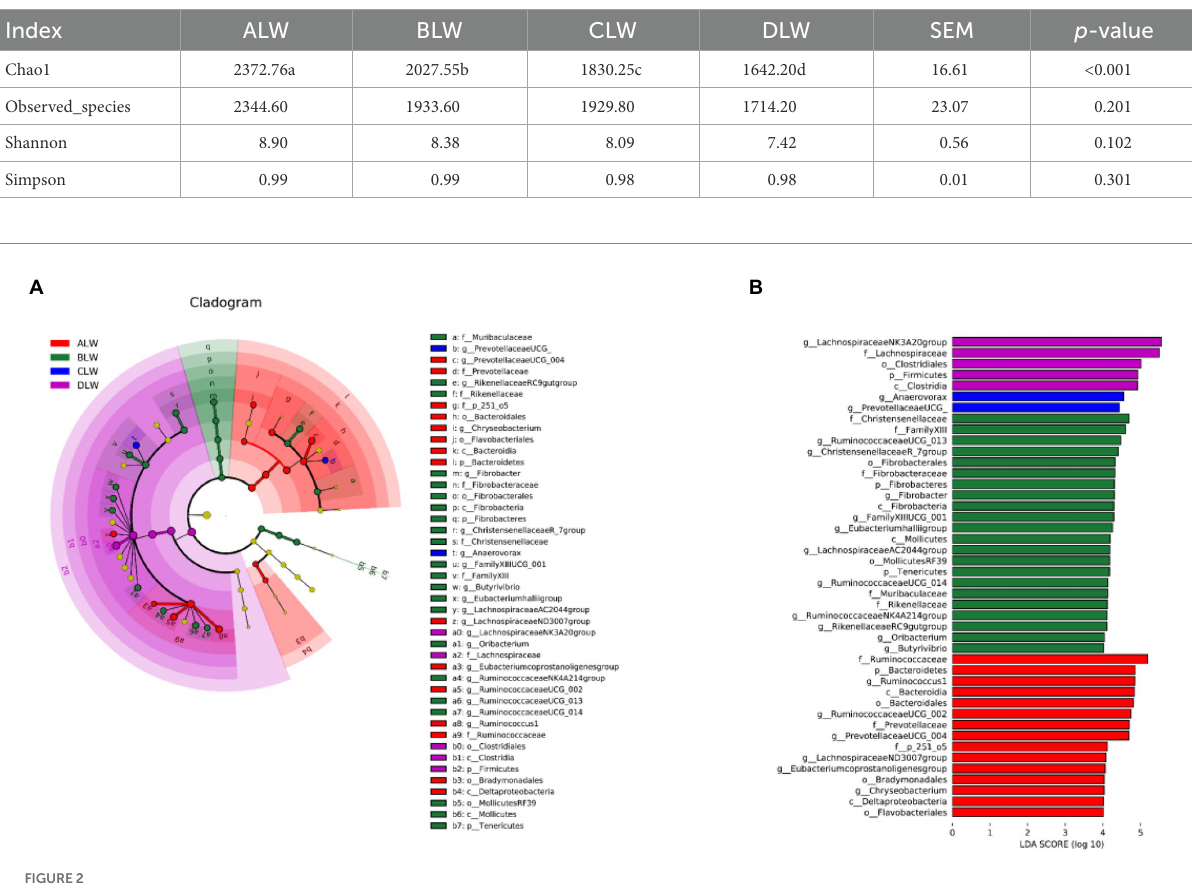
TABLE 2 Effect of EOZB on duodenal alpha diversity index.